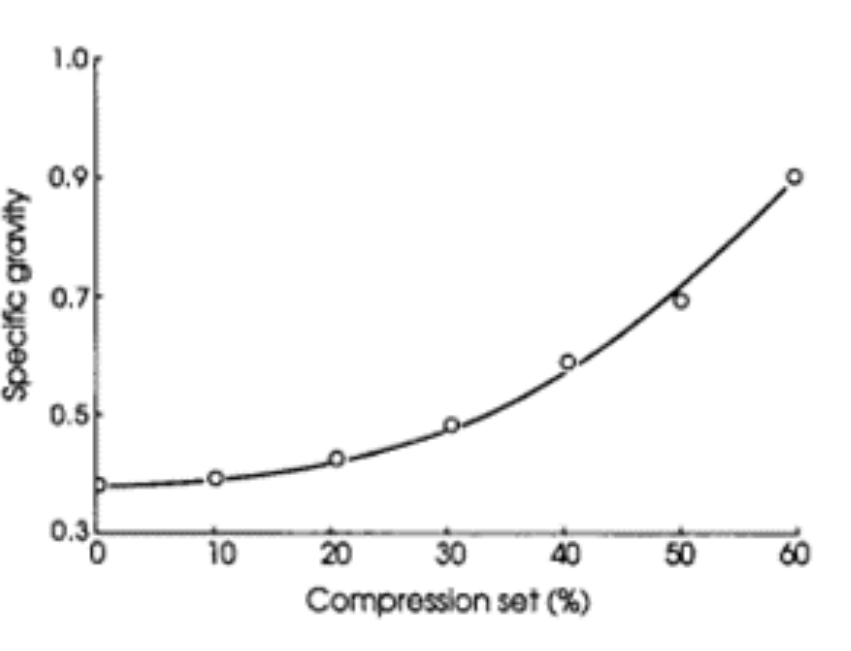
( B ) Figure 11. Scanning micrograph of solid wood before polymer impregnation with open lumens ( A ) and after polymer impregnation with filled lumens ( B ).